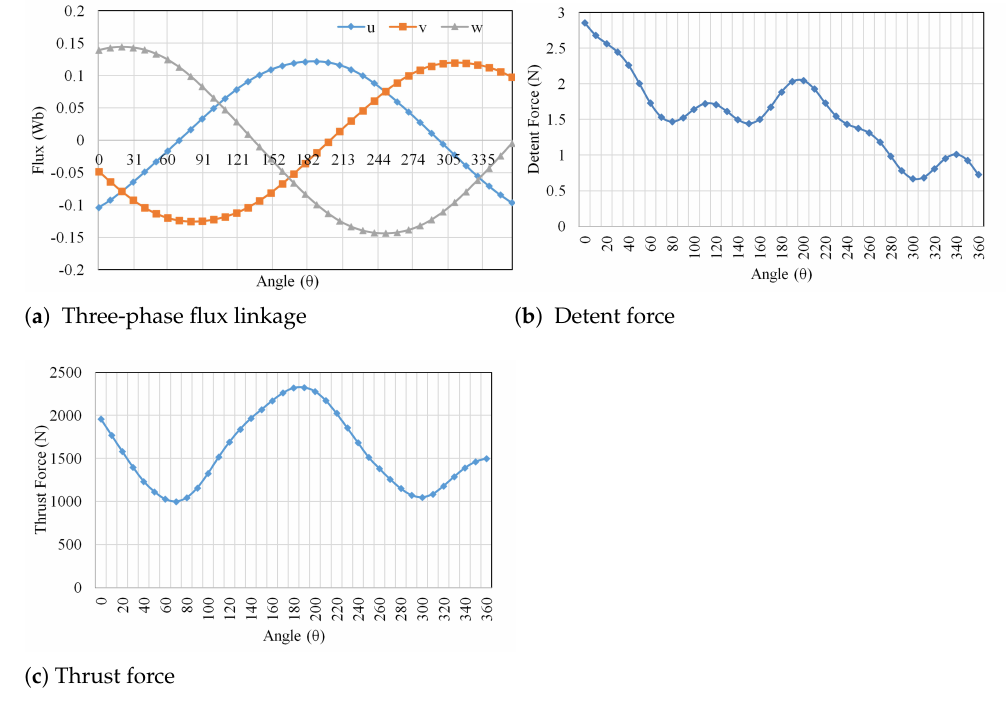
Figure 4. Initial design performance